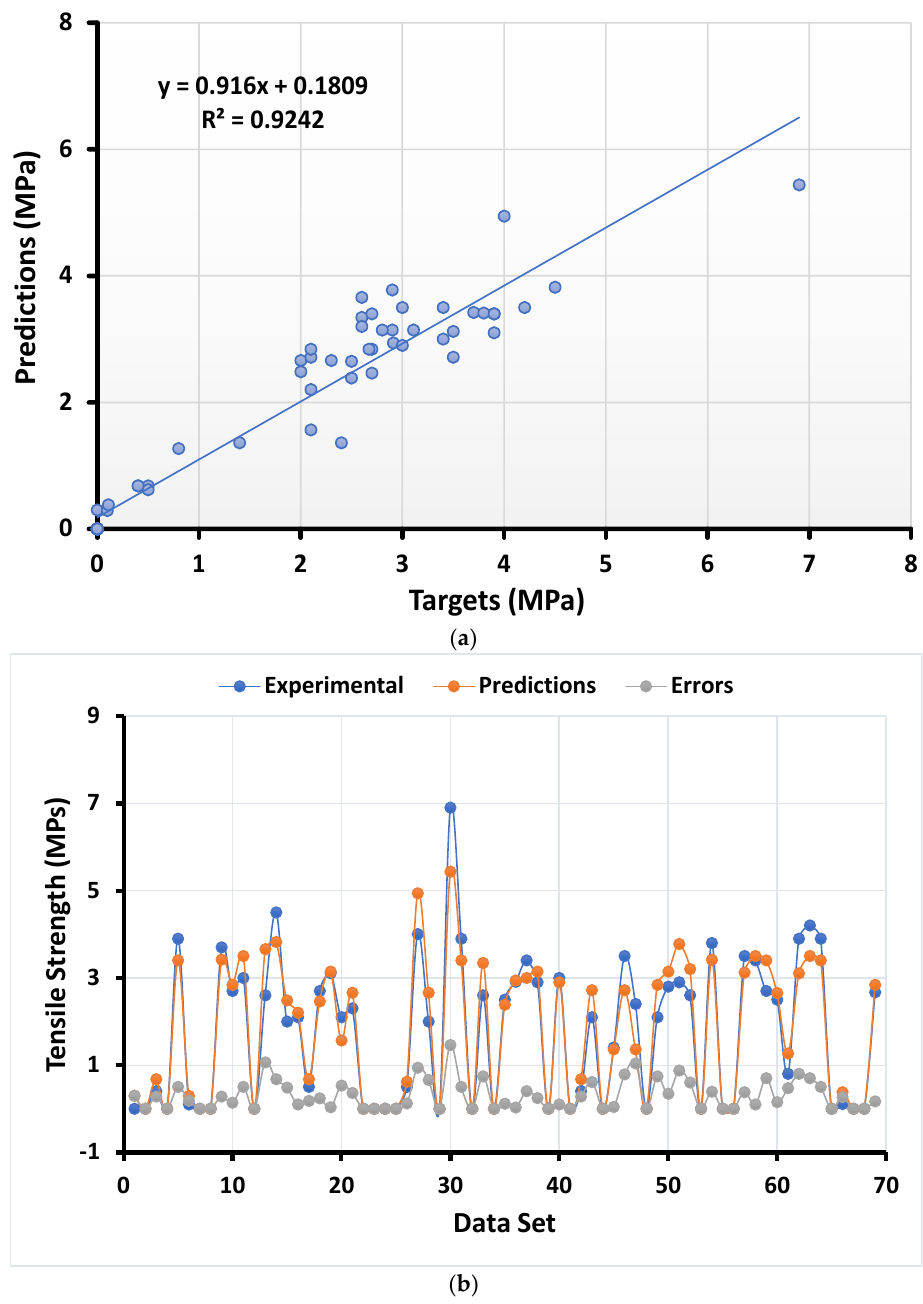
Figure 6. Numerical analyses representing the relationship between the predicted variables and targeted variables ( a ) along with their error distribution ( b ) for splitting tensile strength using the AdaBoost regressor.